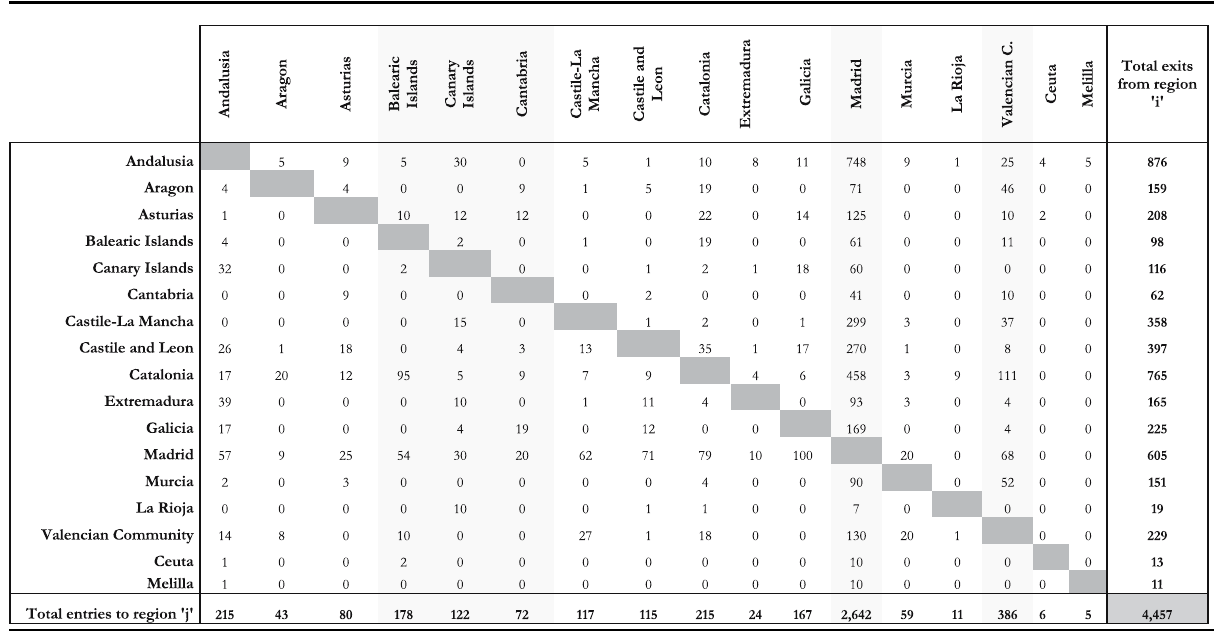
Table 4: Number of changes of residence among top - percentile taxpayers between the source region “ i ” ( residence in 2006, column 1 ) and the destination region “ j ” ( residence in 2012, row 1 ) . Population data*